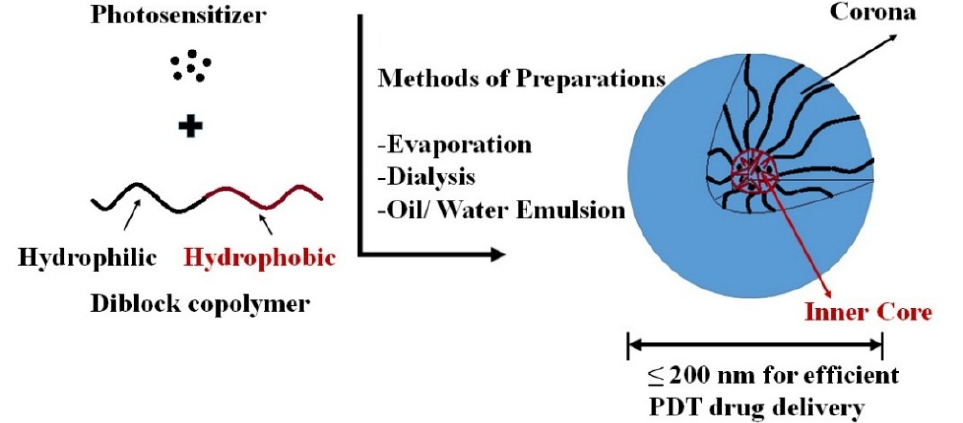
Figure 7. Schematic representation for spherical polymeric micelle formation via